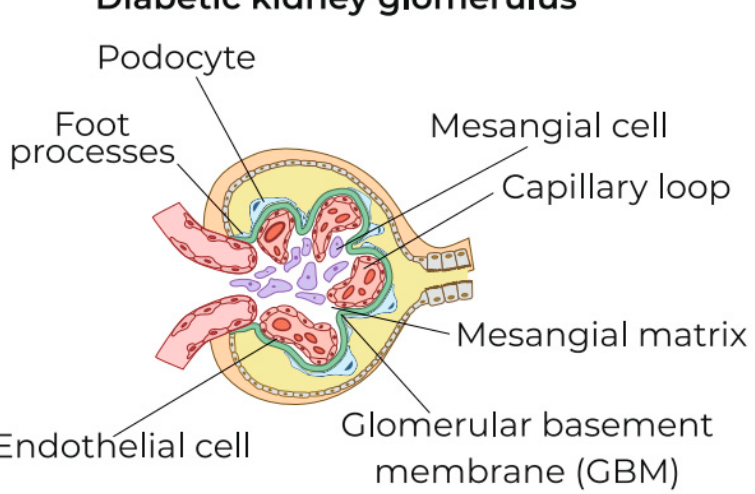
Figure 2. Characteristic features of local low-cell inflammation in the renal corpuscles in diabetic kidney disease. Note: The typical initial changes in the renal corpuscles in diabetic kidney disease are the activation and proliferation of mesangial macrophages, thickening of GBM, a decrease in the number of podocytes, and the density of their processes. However, signs of canonical inflammation have not yet been expressed: there is no exudation (with deposition of fibrin and complement factors and significant migration of leukocytes into the intercapillary space of the renal glomeruli and the cavity of Bowman’s capsule.